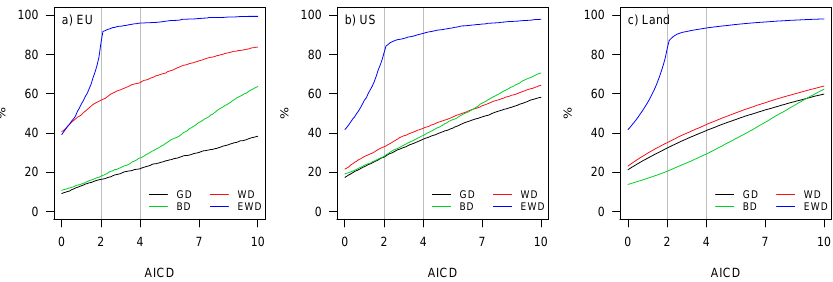
Fig. 10. AICD frequencies (ECHAM5 data set): percentages of all grid points and months a distribution yields AICD smaller or equal than a given value for a) the European region, b) the contiguous United States and c) global land areas. AIC comparison with GD, WD, BD and EWD.